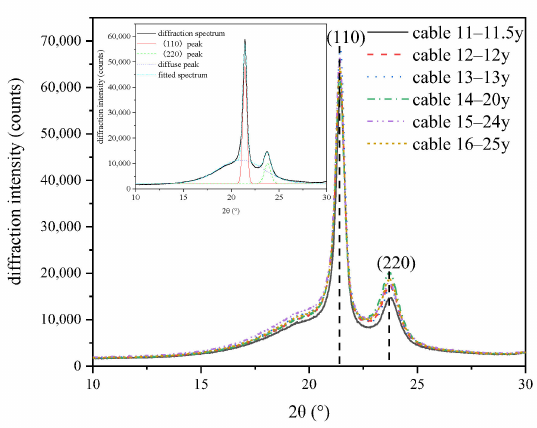
Figure 3. The XRD spectrum of XLPE samples of cables with different service time.